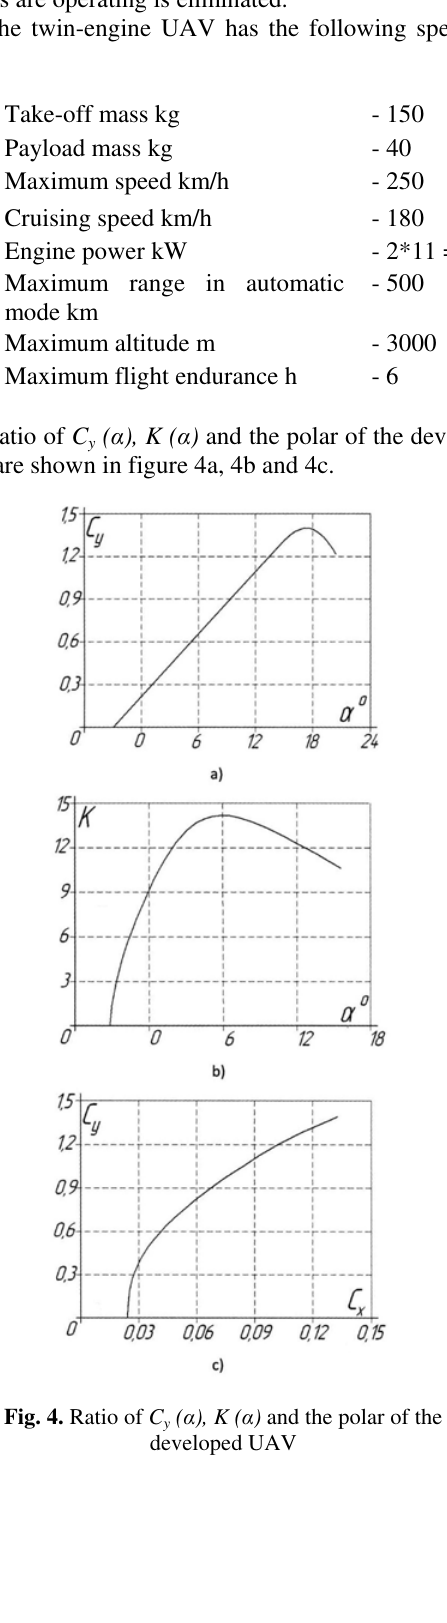
( α ), K ( α ) and the polar of the y developed UAV